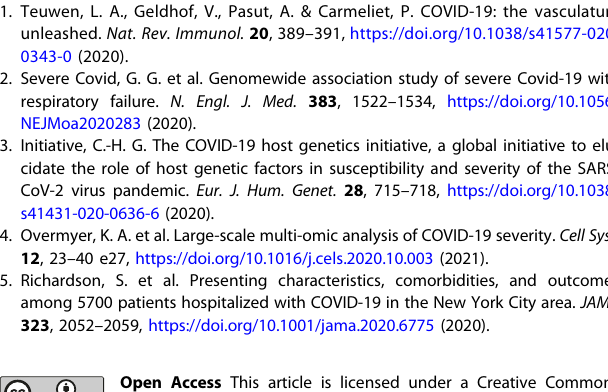
fi tted the model with z-score normalized values, the coef fi cients of each contributing variable can be compared directly. We observed that age is the most important risk factor for COVID-19 severity, and male sex, high BMI, and history of COPD, CAD, and T2DM are also effective predictors (Fig. 1i), which is consistent with previous fi ndings. Notably, VWF PRS showed a